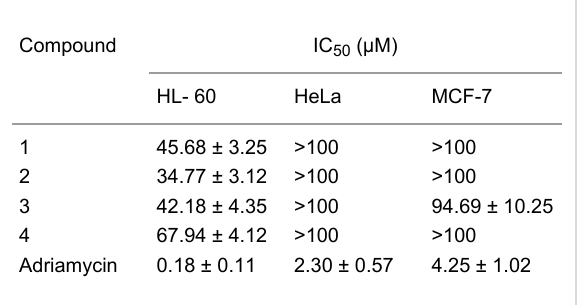
Table 4: Cytotoxic effects of compounds 1 – 4 against HL-60, HeLa, and MCF-7 cells.